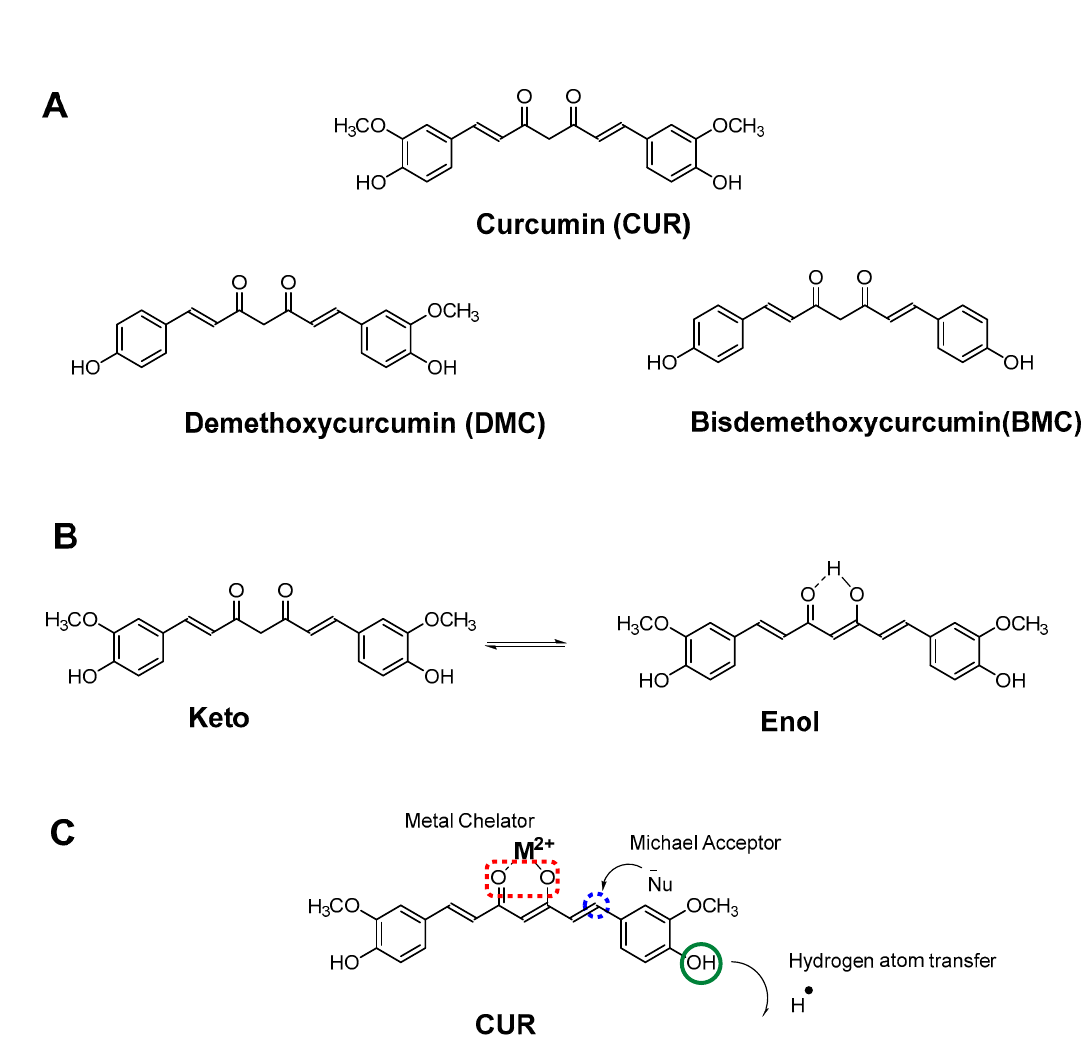
Figure 2. ( A ). Chemical structures of curcuminoids, ( B ). Keto-enol tautomers of curcumin, and ( C ).